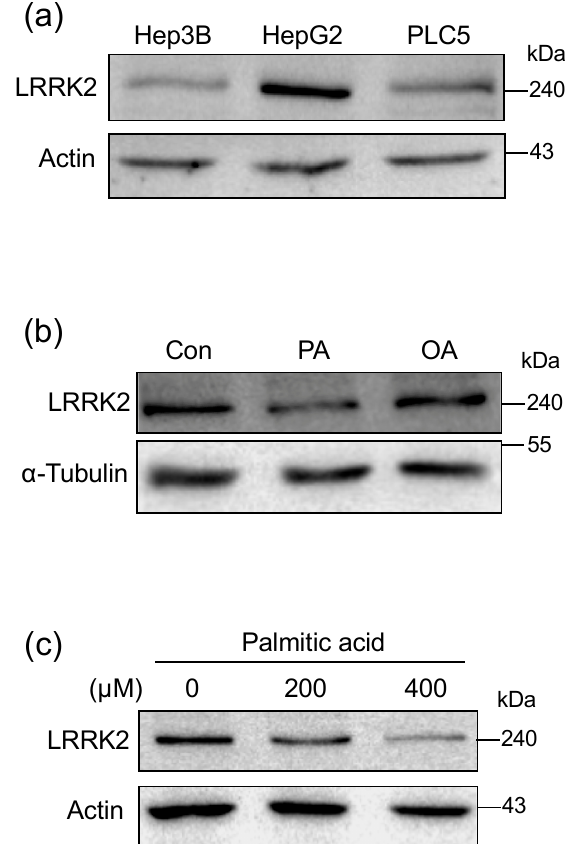
Figure 2. Palmitic acid reduced the expression of LRRK2 in HepG2 cells. ( a ) Western blots were used to detect the presence of LRRK2 in the liver cell lines, Hep3B, HepG2, and PLC5. ( b ) A western blot was used to analyze the levels of LRRK2 protein in HepG2 cells treated with vehicle, 400 µ M PA, or 400 µ M OA, respectively. HepG2 cells were treated with indicated fatty acids for 24 h. ( c ) Protein levels of LRRK2 in the HepG2 cells treated with PA at indicated concentrations for 24 h and analyzed by western blot.